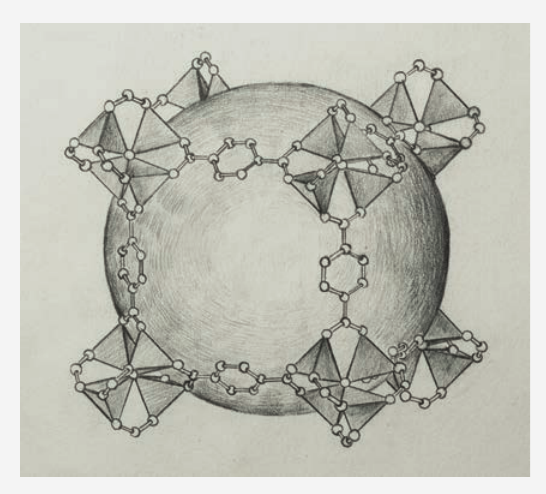
Fig. 2a. The crystal structure of MOF-5 showing Zn 4 O units (corners) linked by terephthalate to make extended 3D structure. The Ball indicates the smallest sphere to fi t the pore without touching the van der Waals radii of framework atoms.